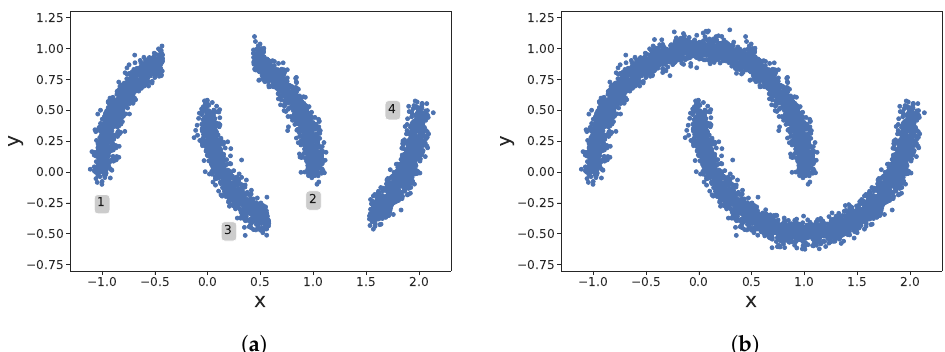
Figure 7. The Moon synthetic dataset. ( a ) The first 3500 samples from the Moon dataset. ( b ) The Moon dataset.